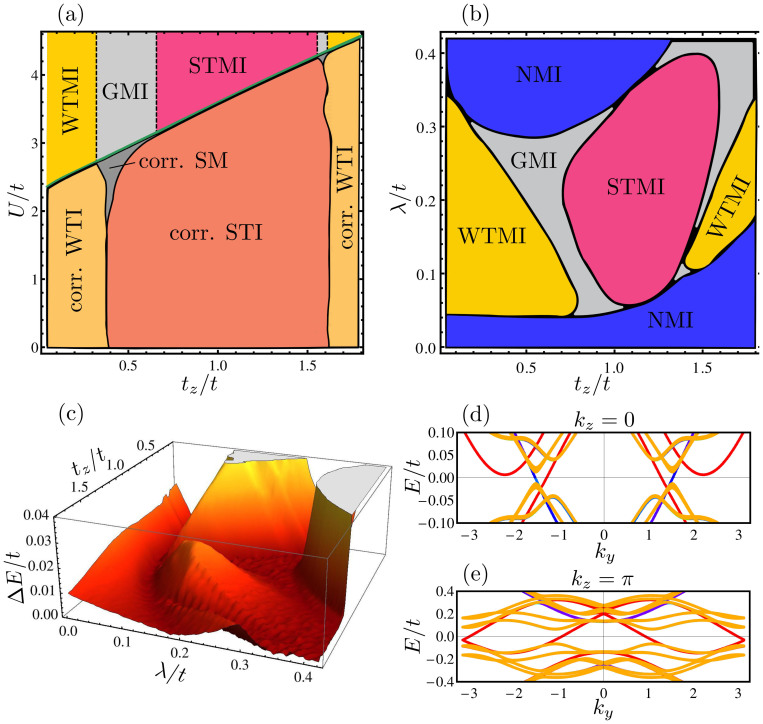
Properties of the interacting system according to slave-rotor theory.(a) Interacting phase diagram as a function of interaction U and hopping tz for fixed λ/t = 0.25. Upon increasing U the phases found at U = 0 remain mostly intact with renormalized parameters. For  an extended correlated semi-metallic (SM) phase appears at . At a critical value Uc/t (green line) the system enters a Mott insulating (MI) state with weak and strong topological MI (WTMI and STMI) as well as gapless MI (GMI) phases. The GMI phase exhibits a semimetallic spinon spectrum. Dashed lines are a guide to the eye showing that Mott phases persist for U > Uc. (b) Interacting phase diagram and (c) bulk gap at Uc as a function of staggering λ and hopping tz. The STMI phase occupies a large part of the phase diagram and features a significant bulk gap. (d–e) One-dimensional cut through the spinon bandstructure in the STMI phase for the isotropic system tz = t and λ/t = 0.15. We use open (periodic) boundary conditions along x (y, z). Bulk states are shown in yellow, gapless spinon edge states at the x = 0 (x = L) edge are shown in blue (red).